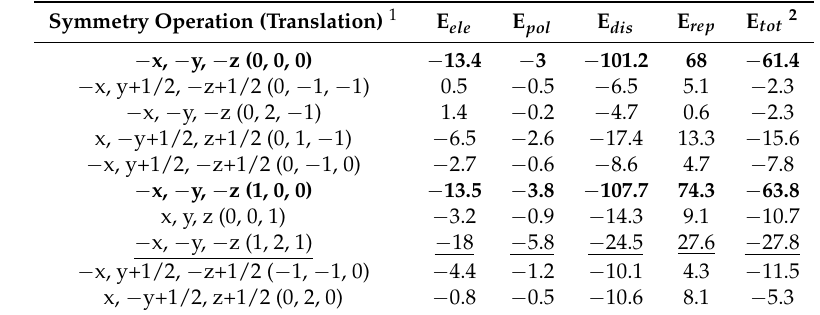
Table 1. The energies of all intermolecular interactions in the crystal structure of 1a as estimated with CrystalExplorer17 [28] in kJ/mol. The total interaction energies for π -stacked molecules in bold, for the strongest H-bond—underlined.